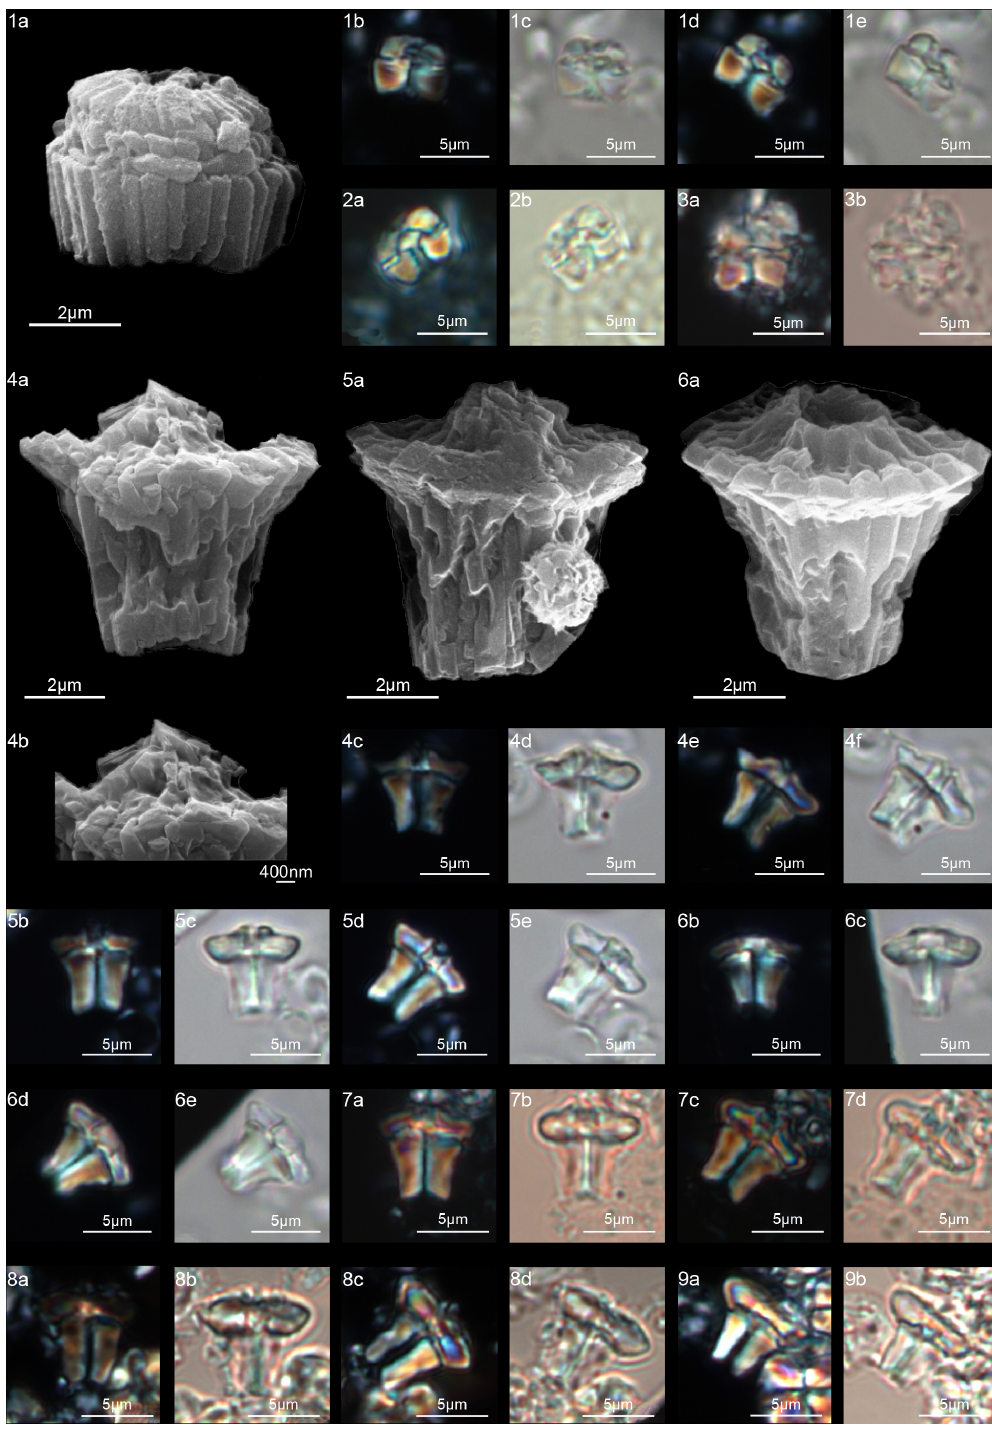
Figure 19. Lithoptychius varolii . (1) Sample: 1209C 14-1, 56–57. (1a) SEM, (1b, d) XPL, (1c, e) PPL. (2) Sample: 1209C 14-1, 56–57. (2a) XPL, (2b) PPL. (3) Sample: Contessa Road 9.50m (above the K–Pg boundary). (3a) XPL, (3b) PPL. Tectulithus janii . (4) Sample: 356Z 23R-1W, 70–71. (4a) SEM, (4b) SEM, detail of tectum. (4c, e) XPL, (4d, f) PPL. (5) Sample: 356Z 23R-1W, 70–71. (5a) SEM, (5b, d) XPL, (5c, e) PPL. (6) Sample: 356Z 23R-1W, 70–71. (6a) SEM, (6b, d) XPL, (6c, e) PPL. (7) Sample: 356Z 23R-1W, 70–71. (7a, c) XPL, (7b, d) PPL. (8) Sample: 1209B 24-5, 8–9. (8a, c) XPL, (8b, d) PPL. (9) Sample: 1209B 24-5, 8–9. (9a) XPL, (9b) PPL. See Table S1 for sample